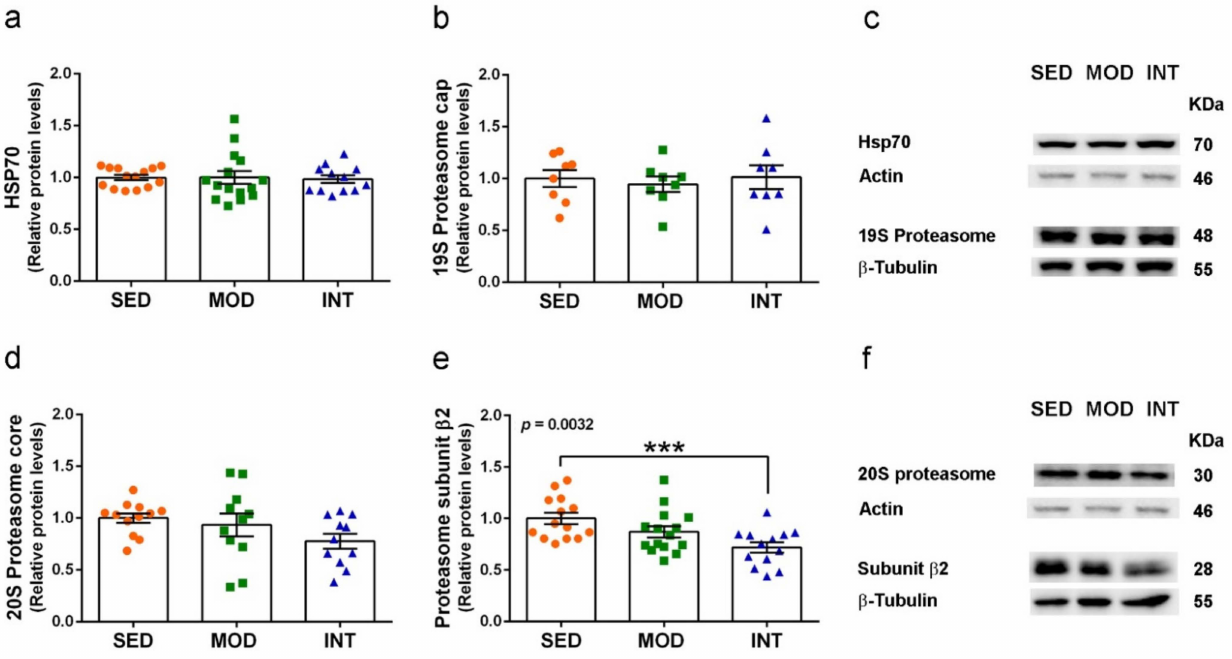
Figure 8. Protein levels of proteasome subunits were modified by exercise. HSP70 ( a ), 19S